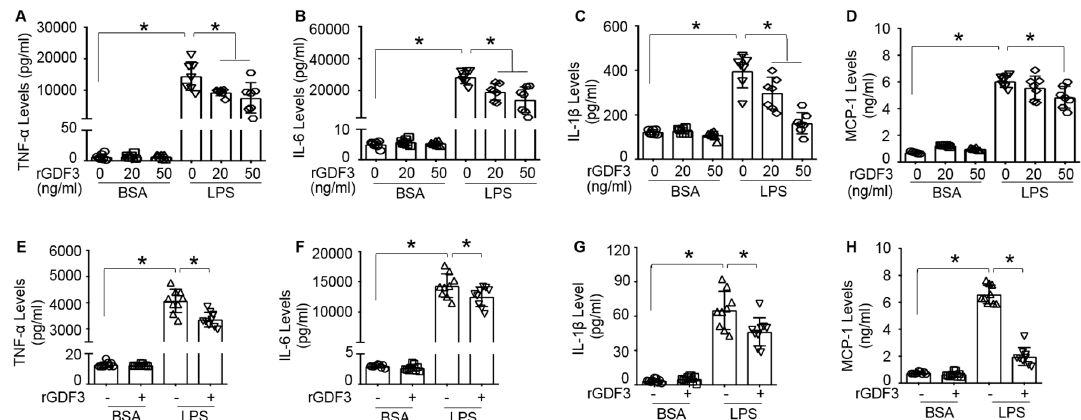
Figure 3. Recombinant GDF3 protein suppresses pro-inflammatory cytokine production in LPS-treated macrophages. ( A – D ) BMDMs treated with the indicated doses of recombinant GDF3 (rGDF3) and ( E – H ) RAW264.7 macrophages treated with rGDF3 (50 ng/mL) for 2 h, followed by addition of LPS (10 ng/mL) for 24 h. Culture supernatants were measured for ( A , E ) TNF- α , ( B , F ) IL-6, ( C , G ) IL- 1 β and ( D , H ) MCP-1 by ELISA (*, p < 0.05; n = 7–9 wells). Similar results were obtained in another separated experiments.